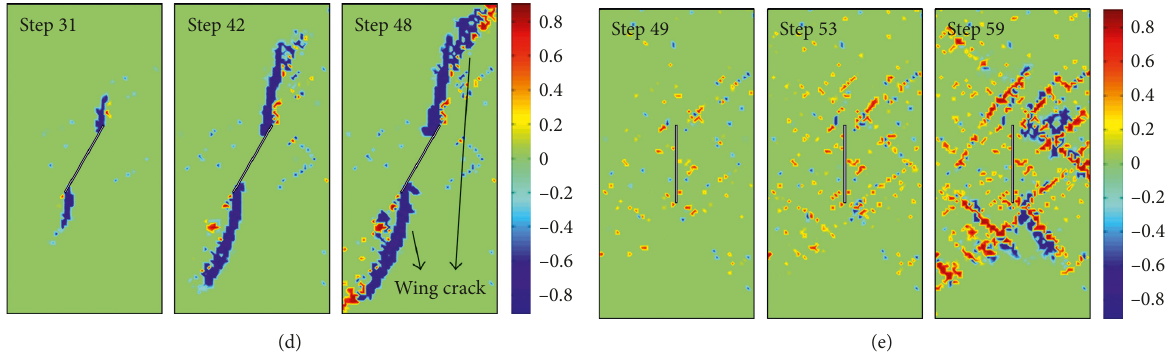
Figure 10: The damage evolution of the samples under uniaxial compression tests with various angles ( α ) of preexisting fracture. (a) α